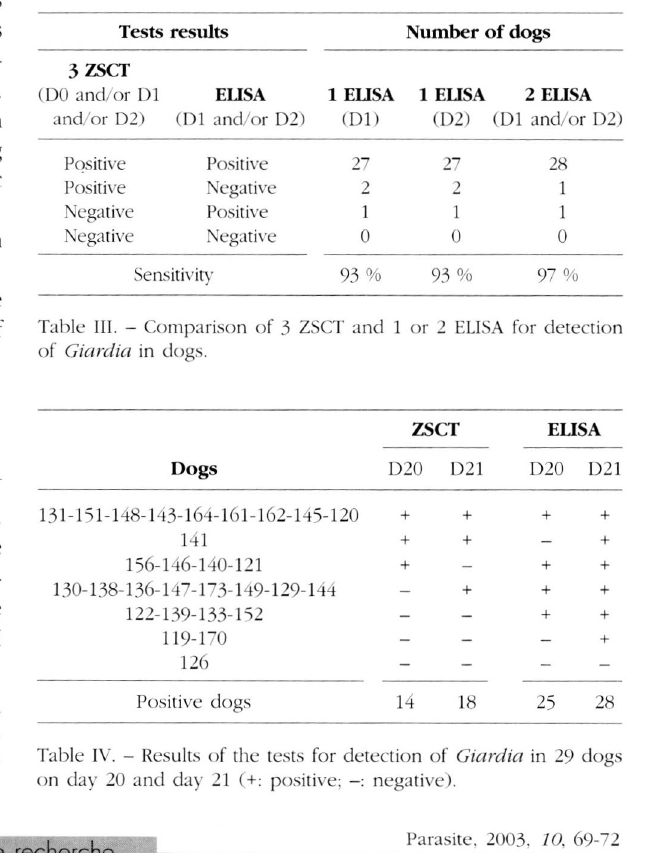
Table IV. - Results of the tests for detection of Giardia in 29 dogs on day 20 and day 21 (+: positive: -: